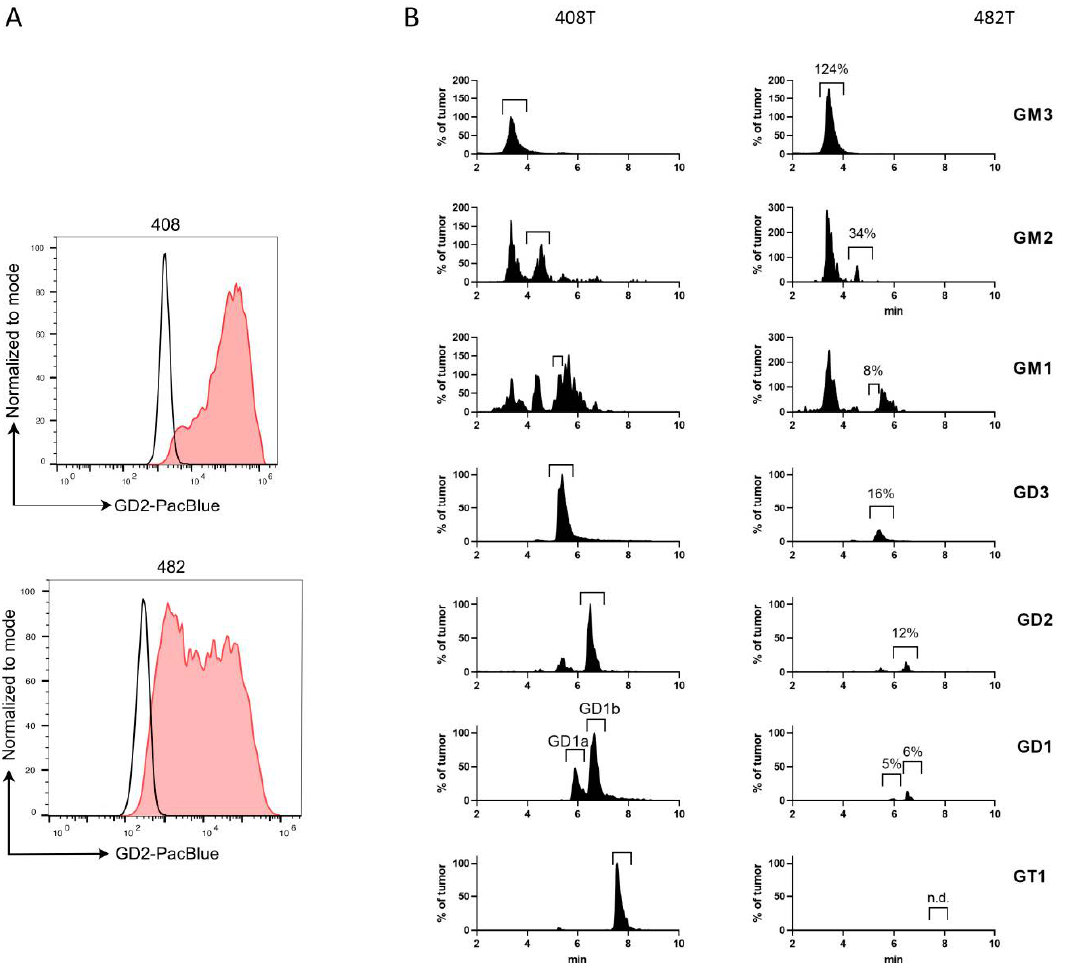
Figure 7. GD2 expression is reduced upon therapy with dinutuximab. ( A ). Expression of GD2 was analyzed by flow cytometry of primary tumor cells isolated before the dinutuximab beta therapy (no 408) or from the cranial metastasis developed under the dinutuximab beta therapy (no 482). ( B ) Liquid chromatography (HILIC)-coupled tandem mass spectrometry showing the composition of gangliosides in one sample of tumor 408T and 482T. 408T is the spinal metastasis that was used to isolate primary cells no 408. 482T is the intracranial metastasis used to isolate primary cells no 482 and developed under dinutuximab therapy (Figure 6E). Gangliosides were separated from neutral lipids prior to analysis. Tandem mass spectrometry detection was run in MRM mode. Retention times were compared to external standards (not shown). Total intensities were adjusted to corresponding total protein levels and normalized to the corresponding signals of the tumor. Percent (%) values given on the right side are corresponding to respective areas (and not peak